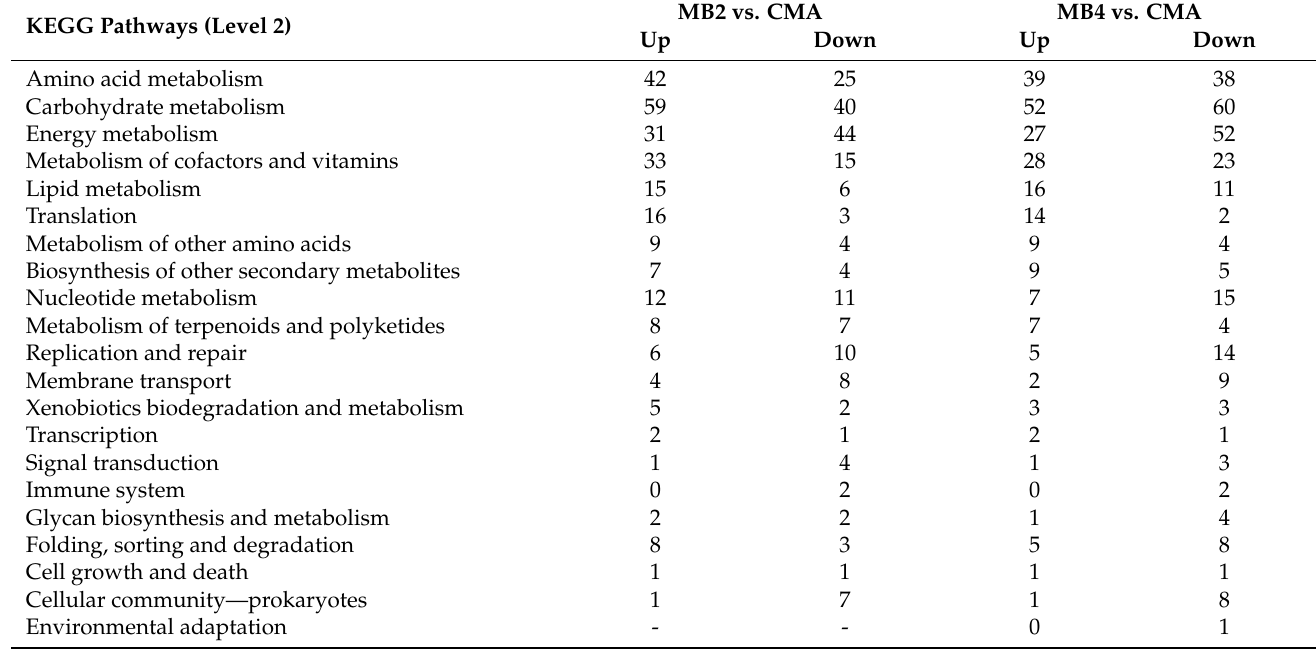
Table 2. Distribution of up- and down-regulated genes in KEGG pathways.